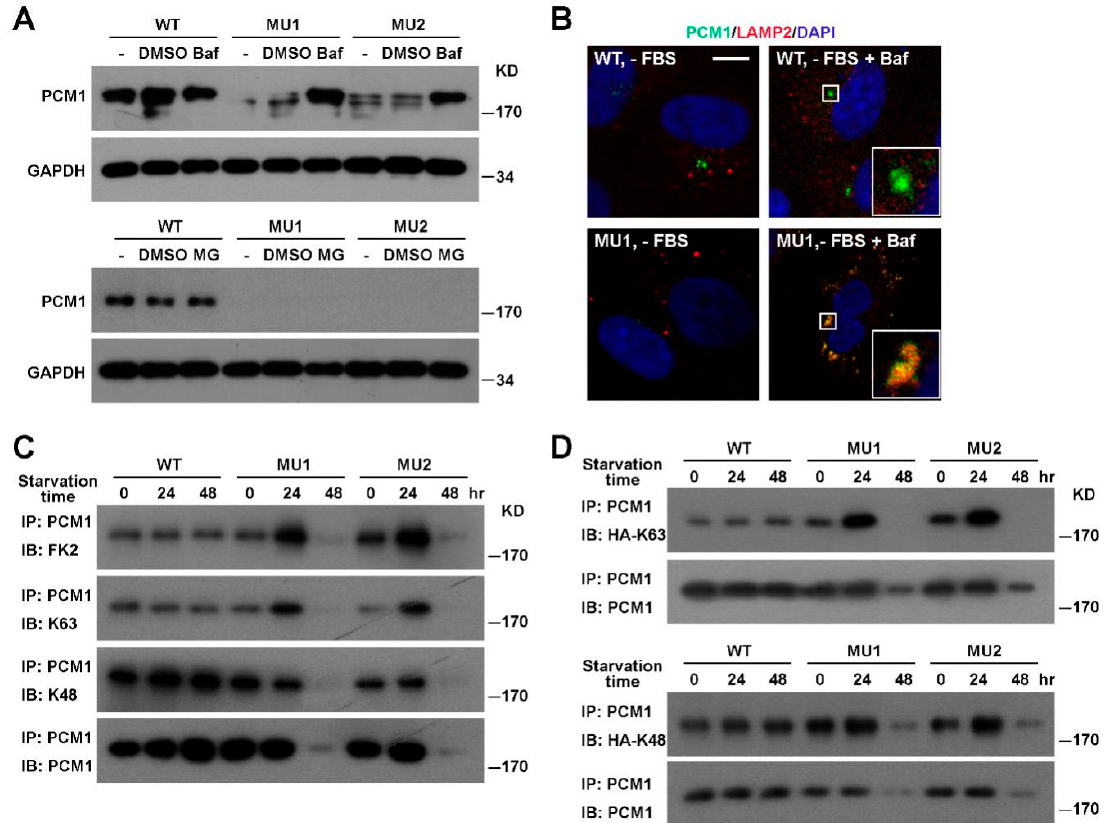
Figure 4. Enhanced K63 ubiquitination and lysosomal degradation of PCM1 in SNX17 mutant cells. ( A ) Pretreatment of mutant cells with the vacuolar-type H + -ATPase inhibitor Bafilomycin A1 (Baf) but not proteasome inhibitor MG-132 (MG) blocked the serum-starvation-induced degradation of PCM1. ( B ) Co-localization of PCM1 with the lysosomal marker LAMP2 was only detected in the presence of Baf in serum-starved mutant cells. Scale bar: 10 µ m. ( C ) Analysis of ubiquitination levels of PCM1 in mutant cells under serum starvation. Monoclonal antibody FK2 recognizes polyubiquitinated proteins while K63- or K48-specific antibodies recognize K63- or K48-linked polyubiquitinated proteins, respectively. K63- but not K48-ubiquitinated PCM1 was accumulated in mutant cells at 24 h after serum starvation. Total PCM1 protein levels in mutant cell lysates at 24 h were comparable to that in WT cells. ( D ) Analysis of PCM1 ubiquitination by K63 or K48 linkage-specific ubiquitin mutant. HA-tagged ubiquitin mutant that can only form K63- or K48-linked ubiquitination were transfected into cells and endogenous PCM1 was immunoprecipitated at the indicated time points and the ubiquitination level of PCM1 determined by western blotting with the anti-HA antibody.